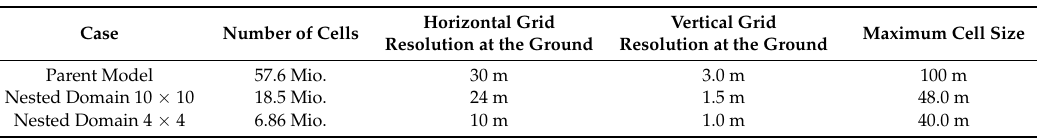
Table 6. Mesh parameters for nested domains.